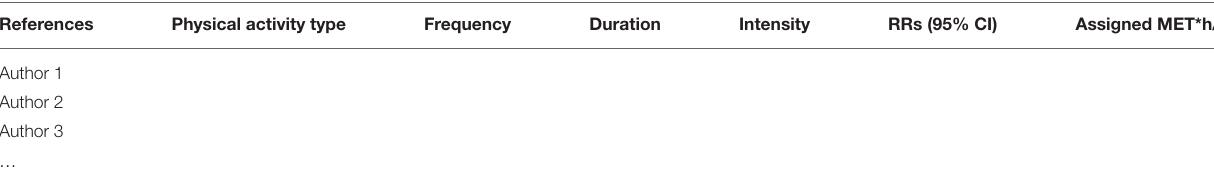
TABLE 2 | Summary of MET*h/week assignment calculations for included